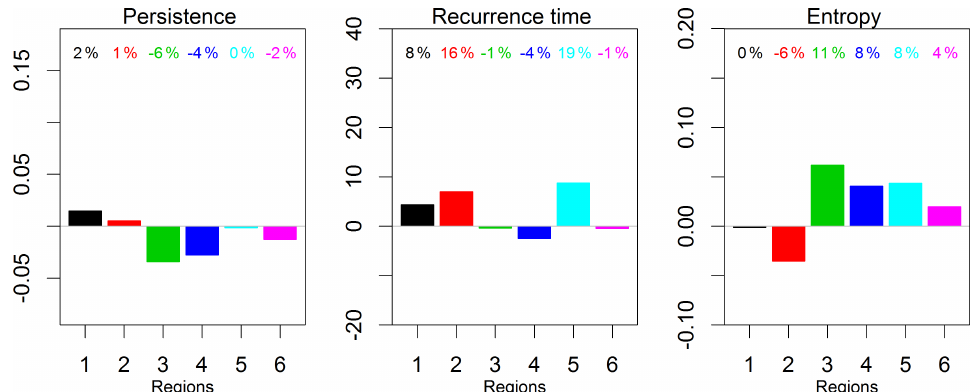
Figure 7. Change signal of descriptors for E-OBS observations: hot and dry extremes in summer (JJA) (Ta > 90th percentile and EDI < 25th percentile). Changes between the time periods 1951–1980 and 1981–2010. Percentages denote the relative change. The coloring corresponds to the regions in Fig. 1.